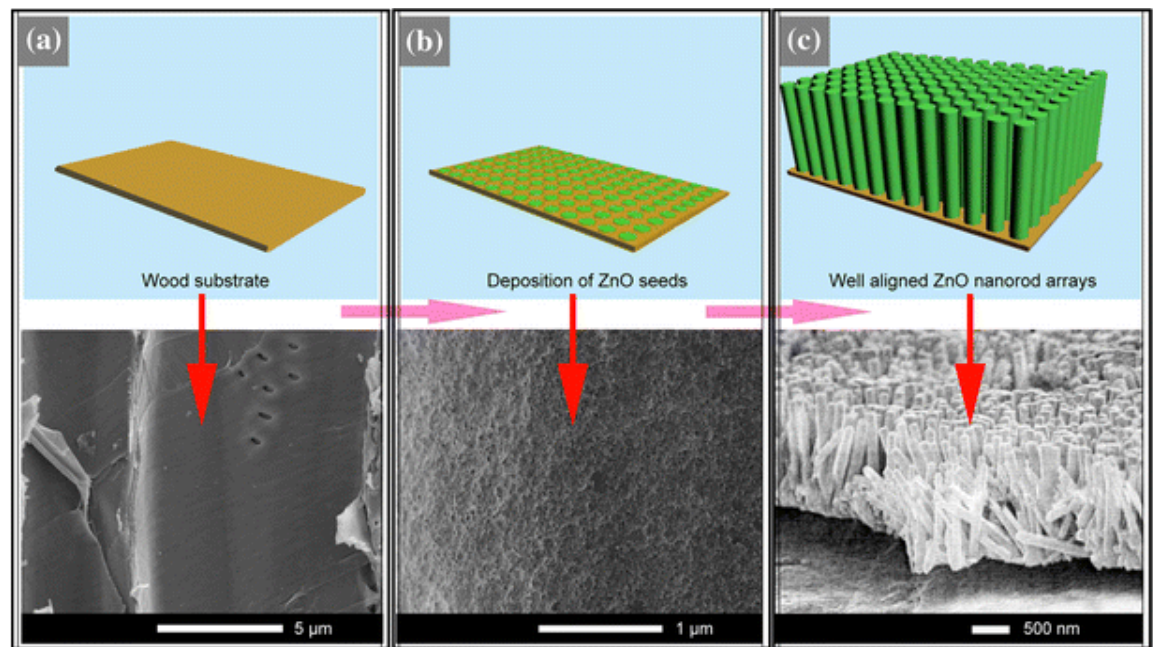
Figure 2. Schematic illustration of the formation process for the ZnO nanorod arrays on the wood surface (( a ): row wood surface, ( b ): densely deposed ZN crystal seed onto wood surface, ( c ): large-scale ZnO nanorod arrays) [96]. Reprinted with permission from Springer Nature: Springer Nature, Journal of Materials Science (Improved UV resistance in wood through thehydrothermal growth of highly ordered ZnOnanorod arrays, Sun, Q. et al.), 2012.